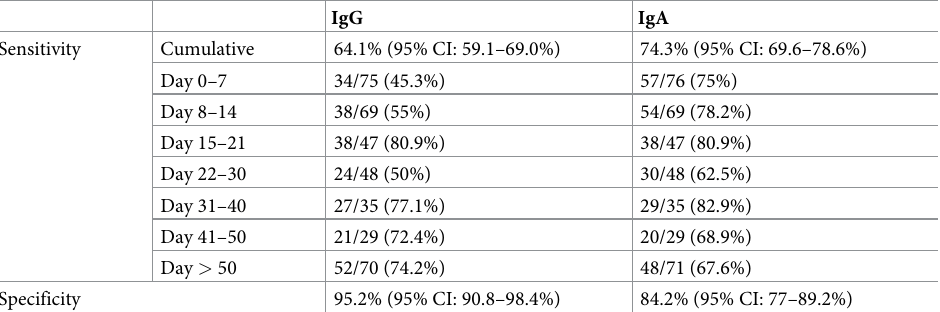
Table 2. Performance characteristics of EUROIMMUN Anti-SARS-CoV-2 IgA and IgG assays against